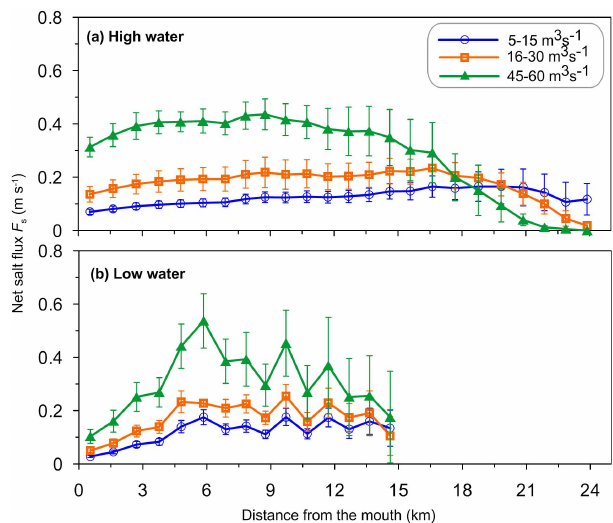
Fig. 8. Response of dispersive salt flux F s (ms − 1 ) to salinity gradi- ent (km − 1 ) at low and high waters along the Sumjin River Estuary under different river